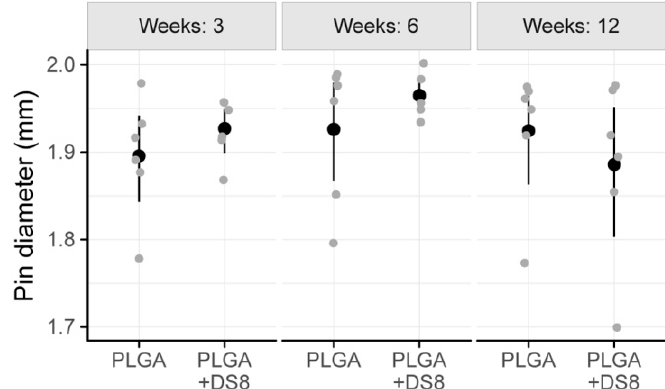
Figure 8. Scatter plot of the diameter of the implants (I.Dm). (Black dots refer to mean values of the respective groups.)